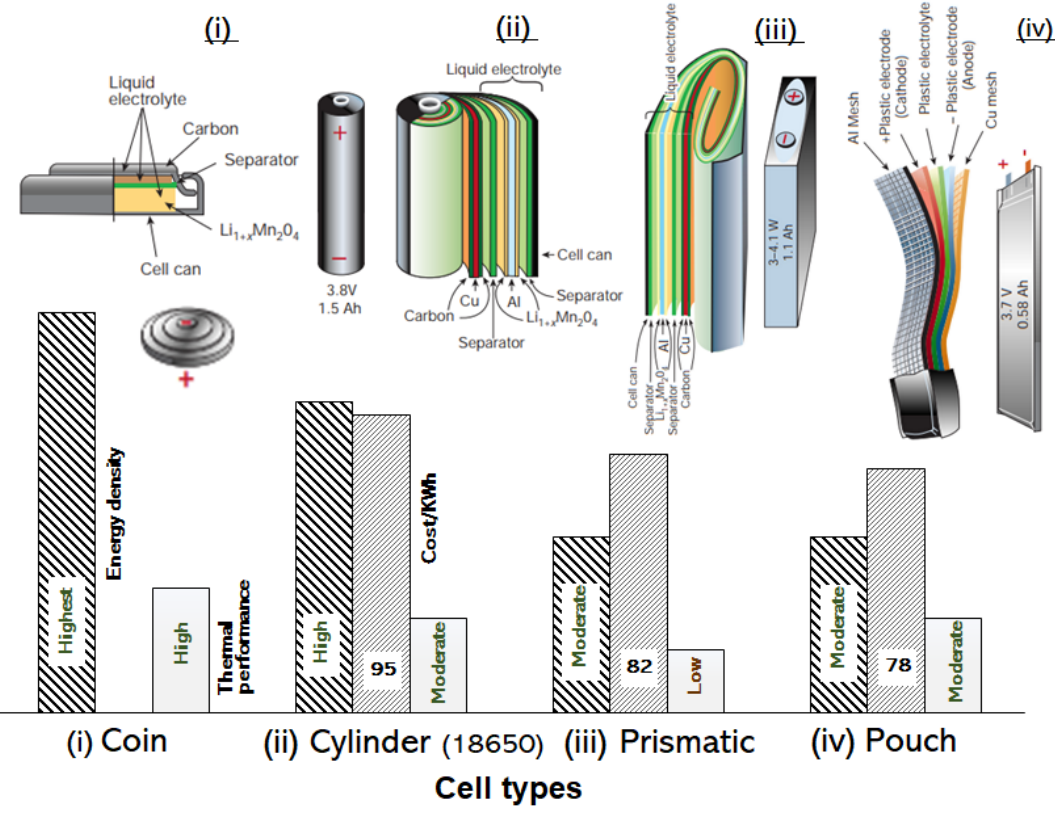
Figure 4. Comparison of key performance parameters of Li-ion cells of primary cell types [33,34] showing cell construction and materials [35]. Adapted with permission from [35]. Copyright 2001 Nature.